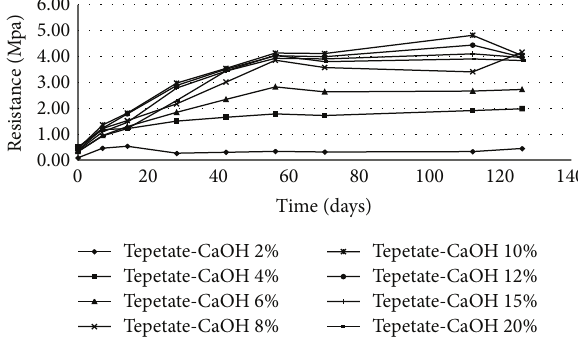
Table 1: Materials standard compaction.